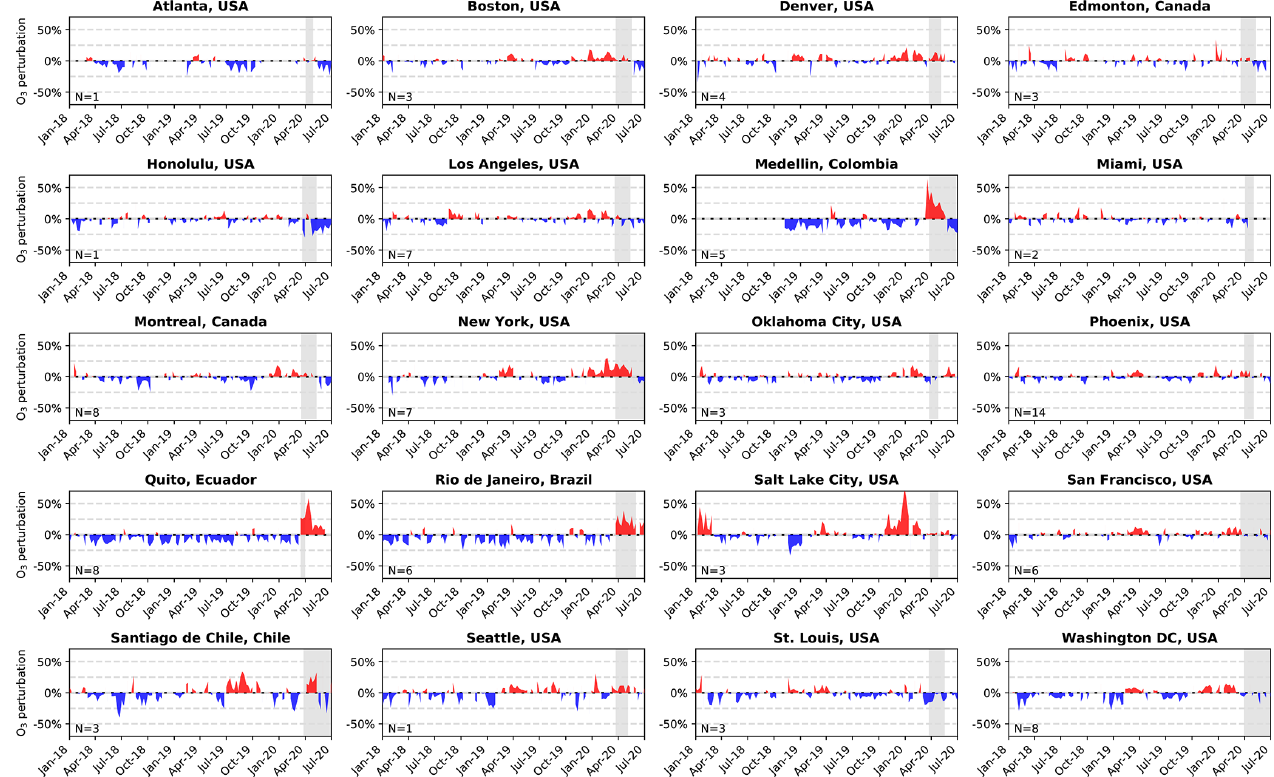
Figure A11. The same as Fig. A9 but for North America and South